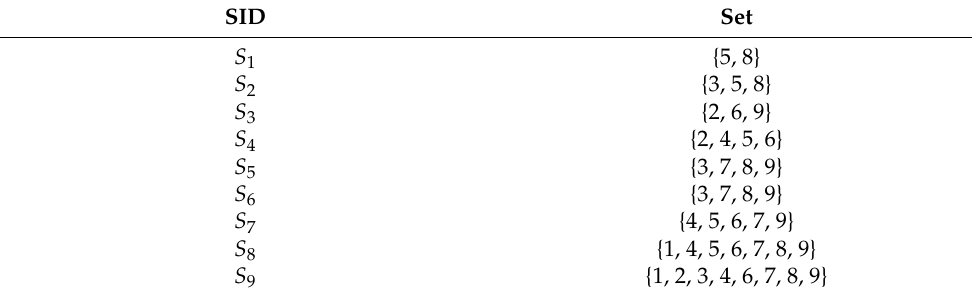
Table 2. The mapped FVA